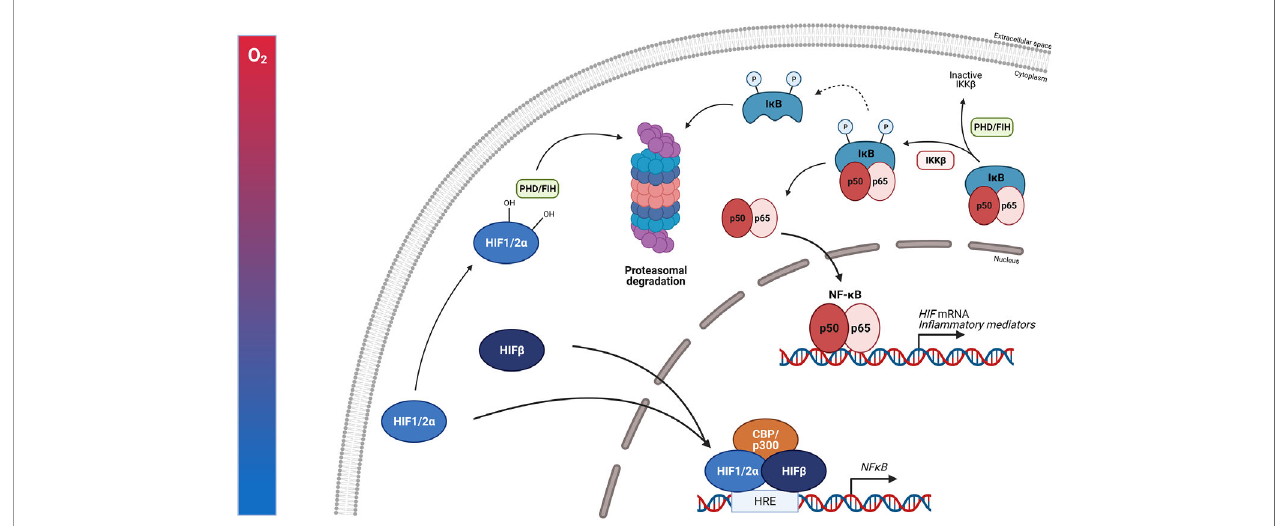
FIGURE 6 | NF- k B protein regulation and the in fl uence of HIF. The expression of NF- k B is induced by in fl ammatory stimuli and hypoxia. Inactive NF- k B is composed of a p50 and p65 subunit. The activation of this complex requires the degradation of inhibitory protein I k B. The phosphorylation of I k B by the b subunit of the I k B complex (IKK b ) leads to the degradation of I k B by the 26S proteasome. Once degraded, the NF- k B heterodimer can translocate to the nucleus where it can activate the transcription of in fl ammatory genes as well as HIF. PHDs and FIH can regulate the activation of NF- k B by controlling the IKK b activity. Upon hypoxia, HIF heterodimers can translocate to the nucleus, bind to HREs and induce the transcription of numerous genes including NF- k B. Figures created with